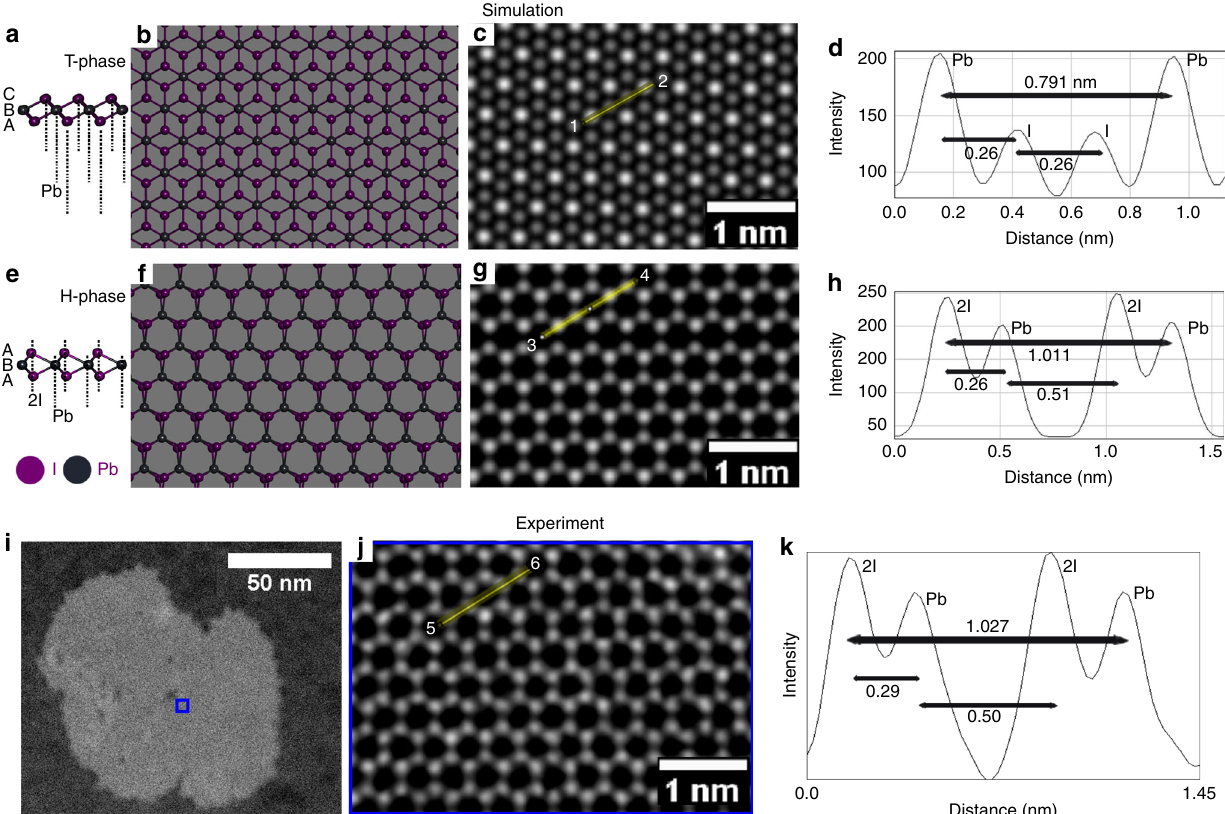
Fig. 2 Atomic resolution ADF-STEM analysis of monolayer 1 H and 1 T phase. a Side view of the 1 T atomic structure of PbI 2 . b Top view of the 1 T atomic model of single layer PbI 2 . c Multislice ADF-STEM image simulation of the 1 T atomic model in b . d Line pro fi le of the lead and iodide intensities marked with yellow line in the atomic model in c , along the direction 1-2. e Side view of 1 H monolayer atomic crystal structure of PbI 2 . f Top view of the 1 H atomic model of single layer PbI 2 . g Multislice ADF-STEM image simulation of the 1 H atomic model shown in f . h Line pro fi le of the lead and iodide intensities marked with yellow line in the atomic model in g , along the direction 3 – 4. i Low-magni fi cation ADF-STEM image of a monolayer PbI 2 fl ake suspended on graphene. j Higher magni fi cation of the region indicated by the blue box in i , showing the 1 H atomic structure. k Line pro fi le taken from region marked by the yellow box in j , which corresponds to same position with the region marked in simulation g , along the direction 5 –